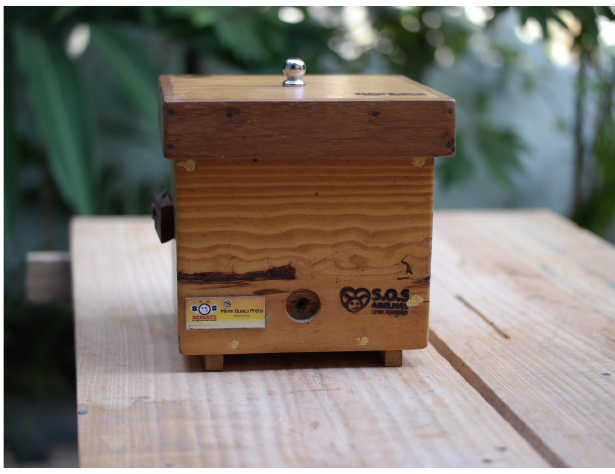
Fig 2 . Closed Hive (Photo by André Matos).